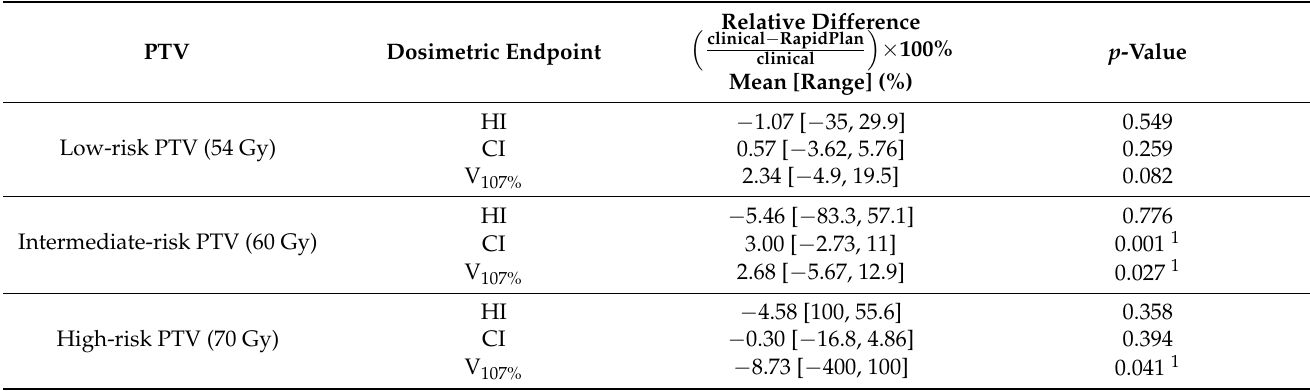
Table 2. Relative differences between clinical and RapidPlan™ plans of the low-risk PTV, intermediate-risk PTV, and high-risk PTV for the open-loop validation set.